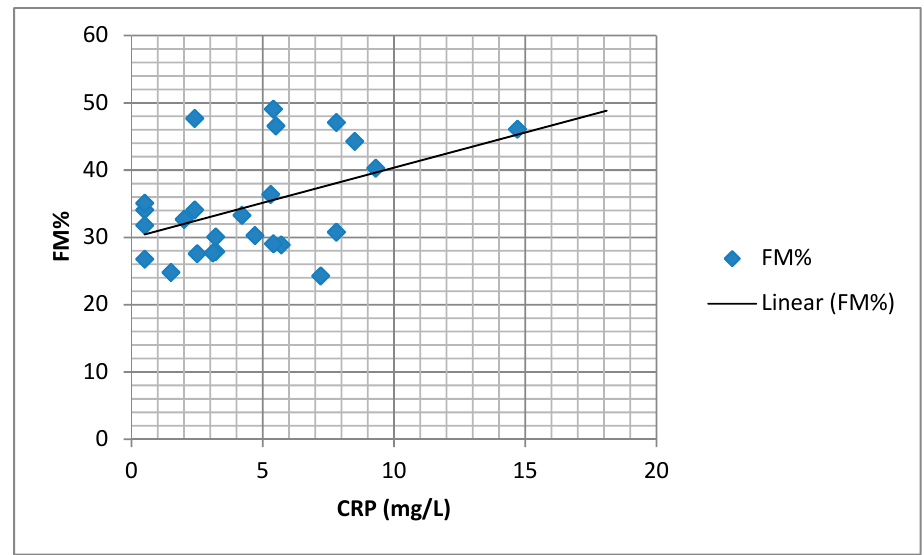
Figure 3. Correlation of serum CRP and body fat percentage (FM%) ( r = 0.450, p = 0.024). A univariate regression analysis determined the following parameters as predictors of serum CRP values: min SatO2, BMI, FM%, and FMI (Table 2). Table 2. Univariate regression analysis for serum C-reactive protein (CRP) values. Univariate Risk Factors Examined # B